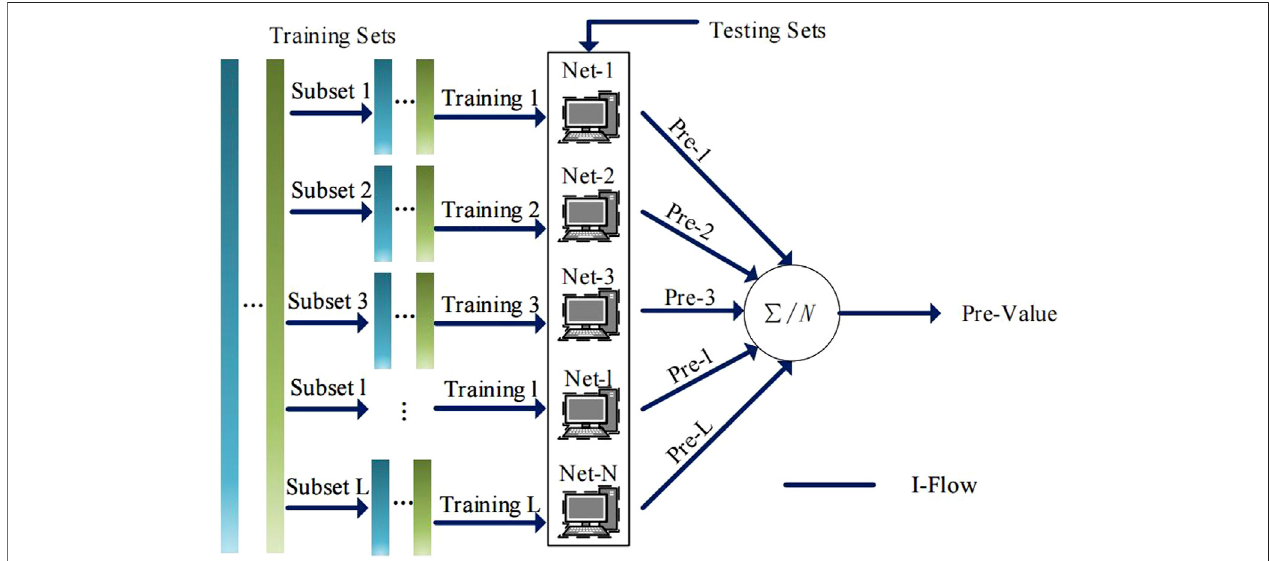
FIGURE 3 | Structure of load forecasting